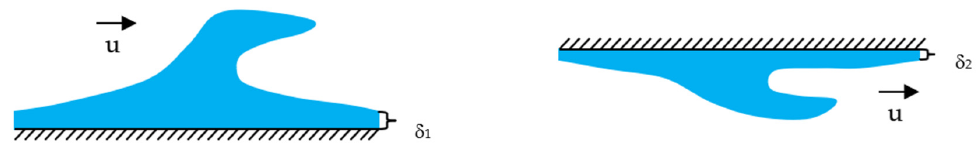
Figure 2. A schematic representation of liquid ‘roll wave’ and film thickness in a horizontal circular pipe: the bottom wave propagation ( left ) and up wave propagation ( right ). Parameter δ represents the liquid film thickness and u is flow velocity.